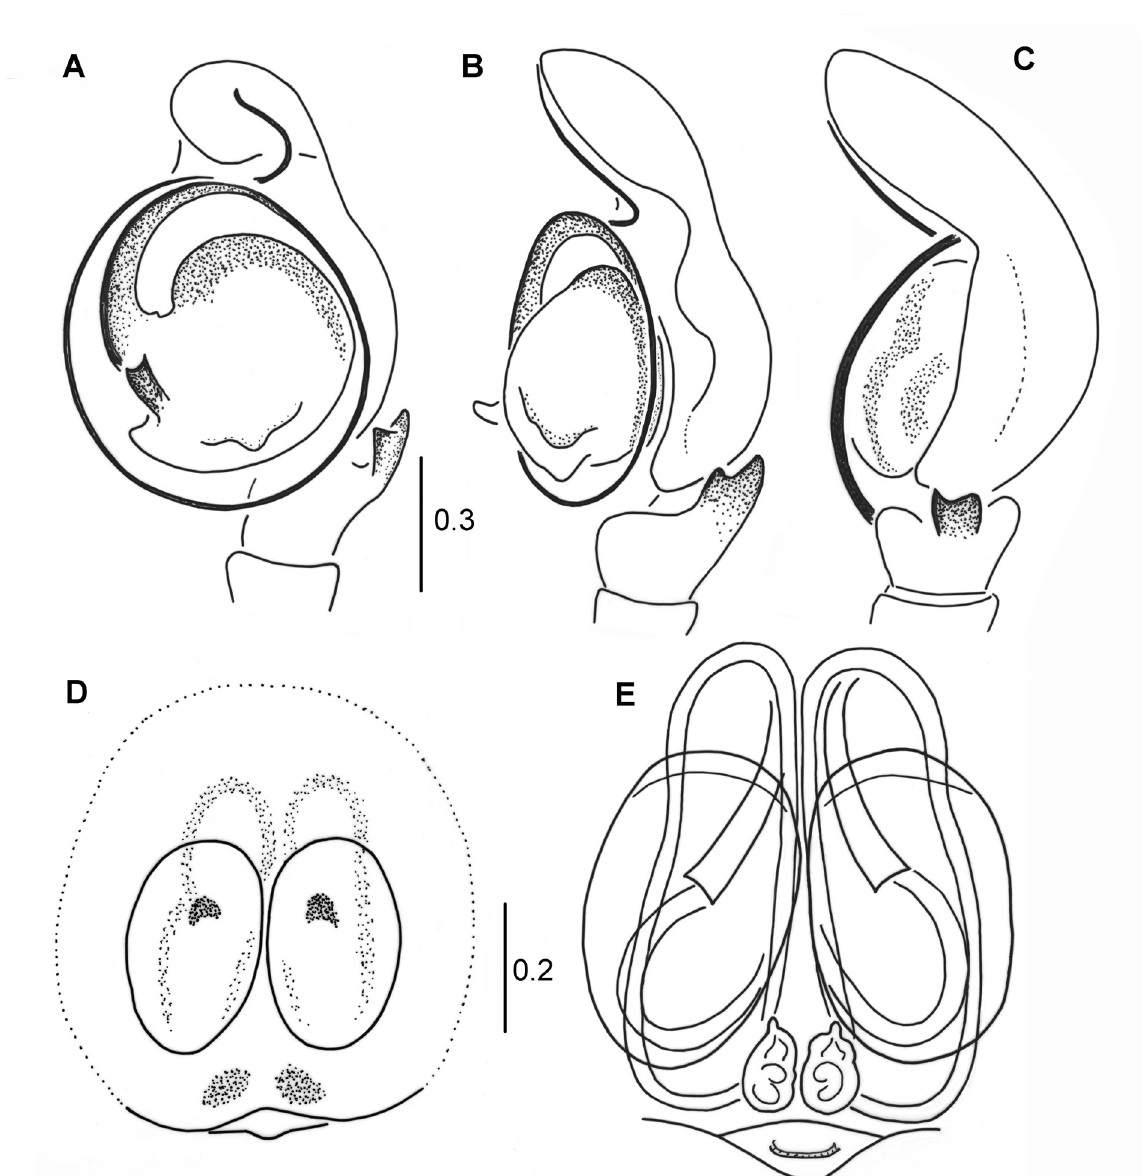
Fig. 8. Bacelarella tanohi Szűts & Jocqué, 2001, ♂♀ (MNHN). A . Palpal organ, ventral view. B . Palpal organ, ventrolateral view. C . Palpal organ, lateral view. D . Epigyne. E . Internal structure of